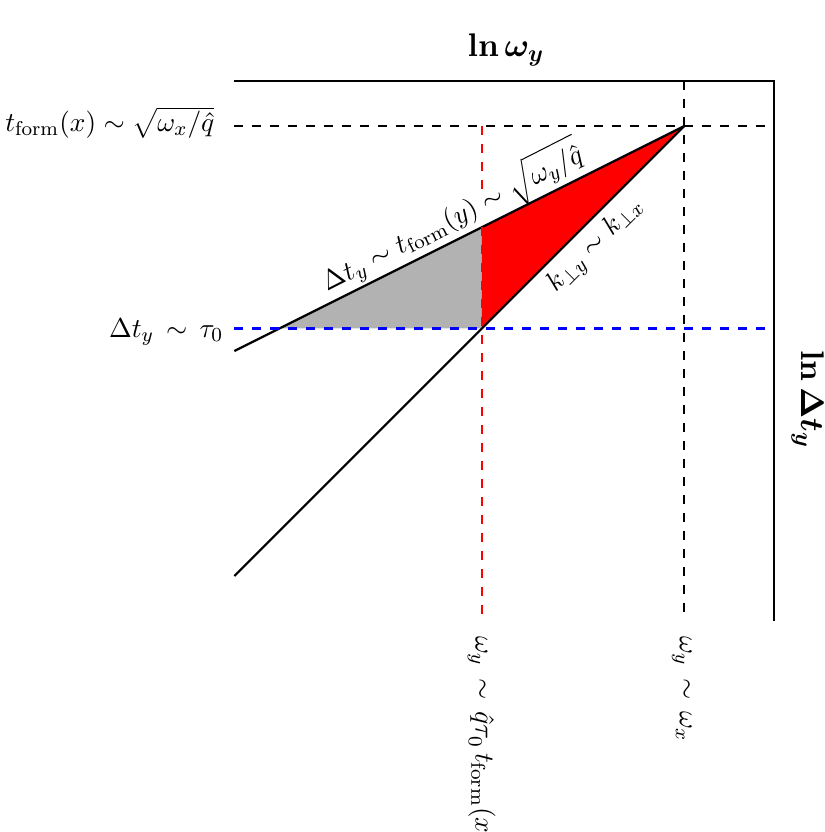
Figure 5 . The double-log region of the soft gluon ( y ) emission parameter space in figure 4 corresponds to all of the shaded regions above. Single logs are determined by the behavior at the boundaries of this region. In this paper, I restrict attention to the red-colored region and the single log contributions from its